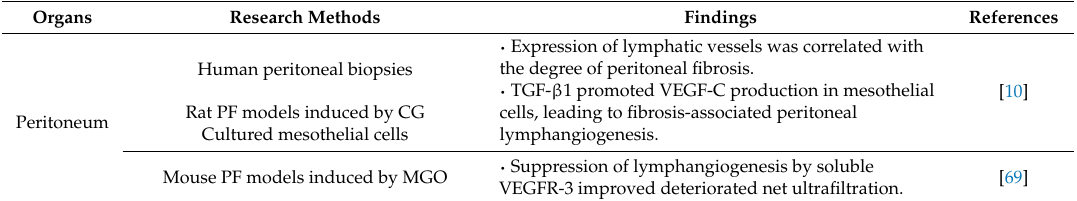
Table 1. Lymphangiogenesis in fibrotic diseases.